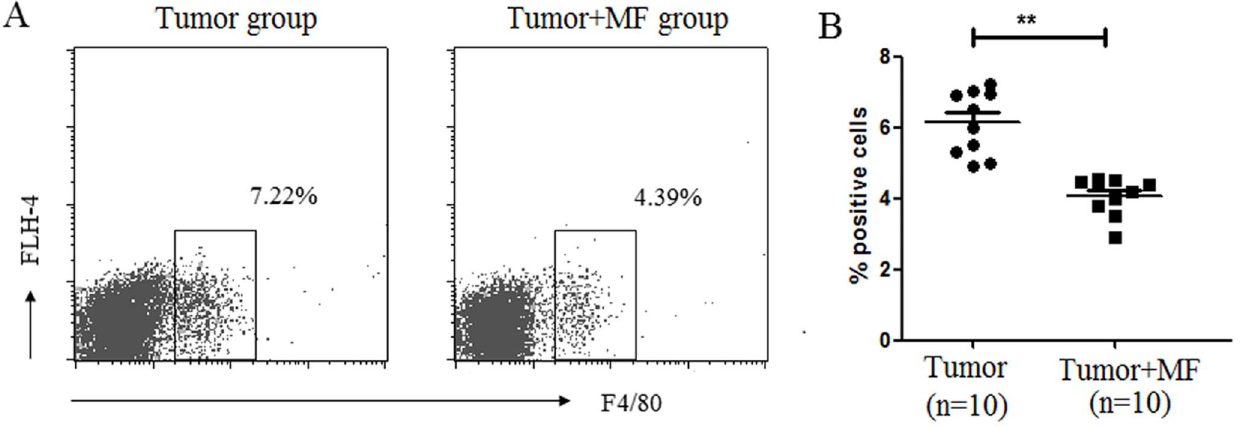
Figure 3. Magnetic fields reverse levels of cytokines/chemokines in plasma of tumor-bearing mice. Bio-Plex was used to analyze cytokine/chemokine changes in mice plasma, (A) IL-6, (B) granulocyte colony-stimulating factor (G-CSF), (C) IL-12p40, (D) Keratinocyte-derived